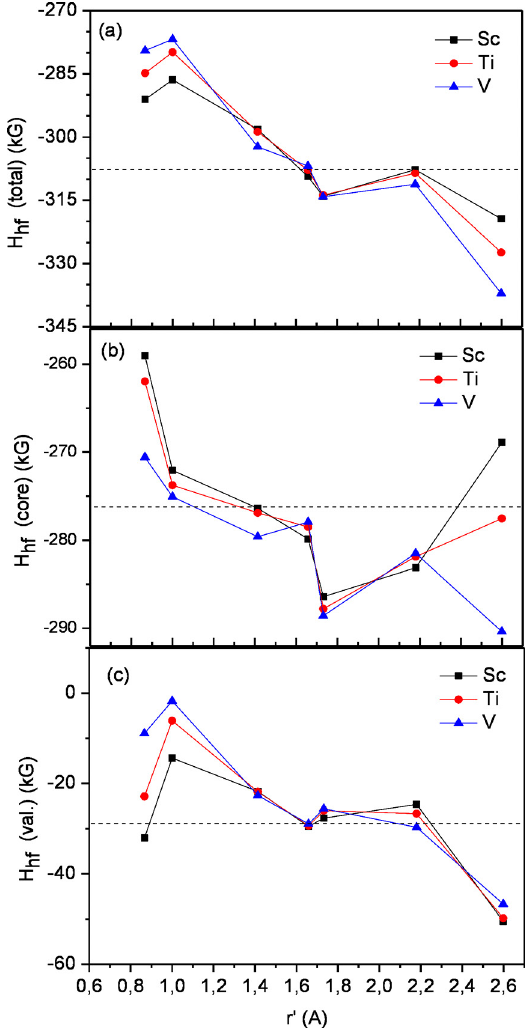
), (b) the core hf ( val )) f